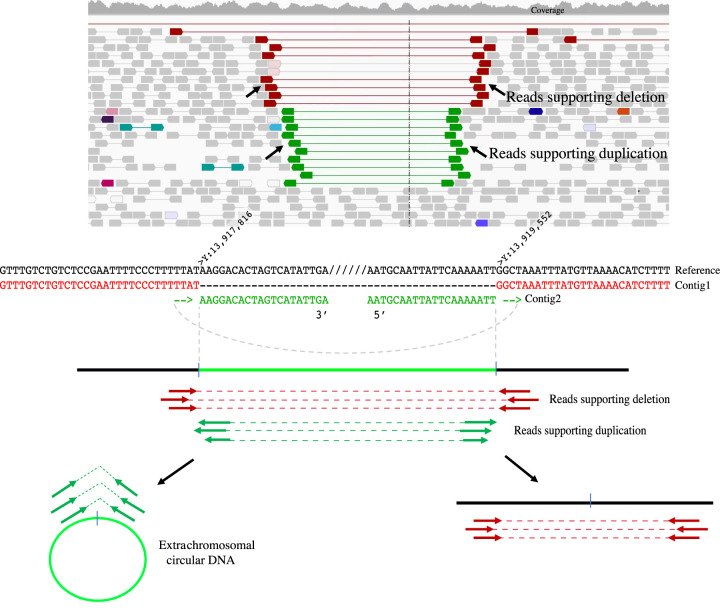
Extrachromosomal circular DNA read support and illustration. We detected a deletion and duplication event in brain B, neuron #12 in the single nuclei data from adult neurons (Lodato et al. 2015). Top panel shows a screen-capture of the region in Integrative Genomics Viewer along with the deletion (red) and duplication (green) supporting reads. Reference sequence around the breakpoints and contigs generated from assembly analysis supporting both deletion (red letters) and duplication (green letters) are represented in the middle panel. The bottom panel illustrates the hypothesis that, given the presence of deletion and duplication supporting reads at the same breakpoints, this event represents an extrachromosomal circular DNA that arises from the deleted region in the reference sequence.